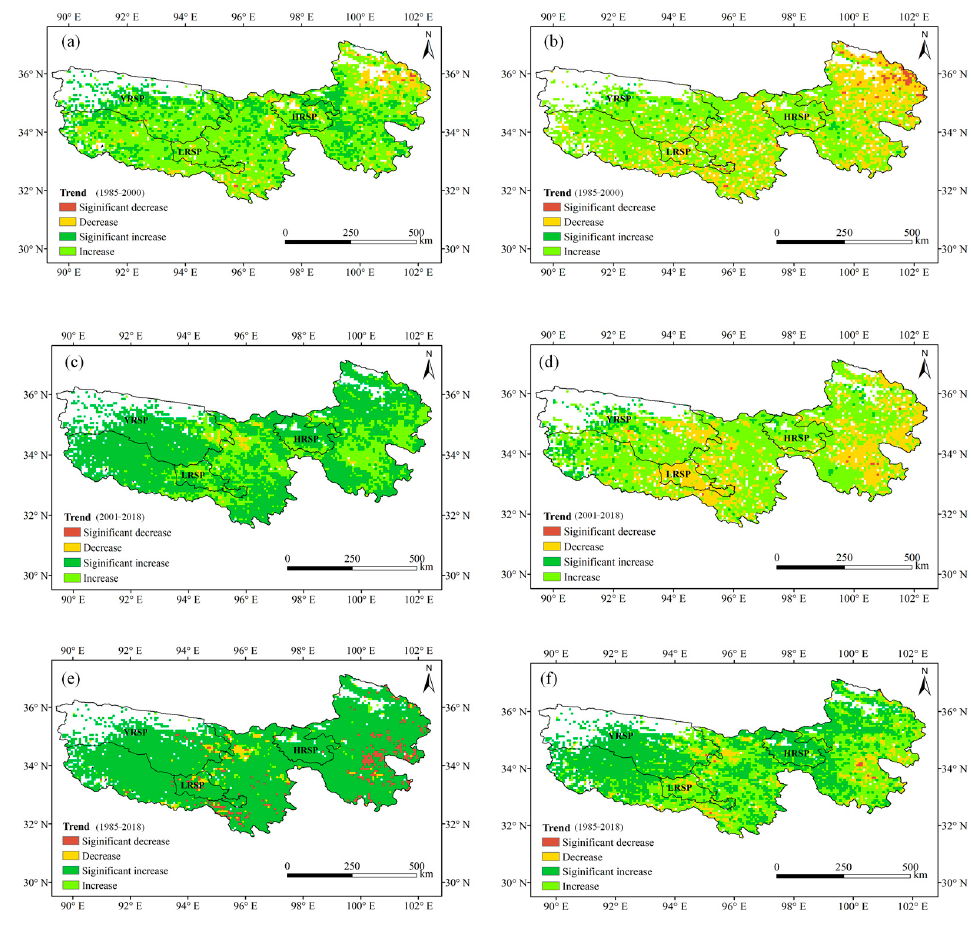
Figure 7. The spatial distribution of the trend of alpine grassland GPP ( a , c , e ) and NEP ( b , d , f ) in the TRSR during the different periods.